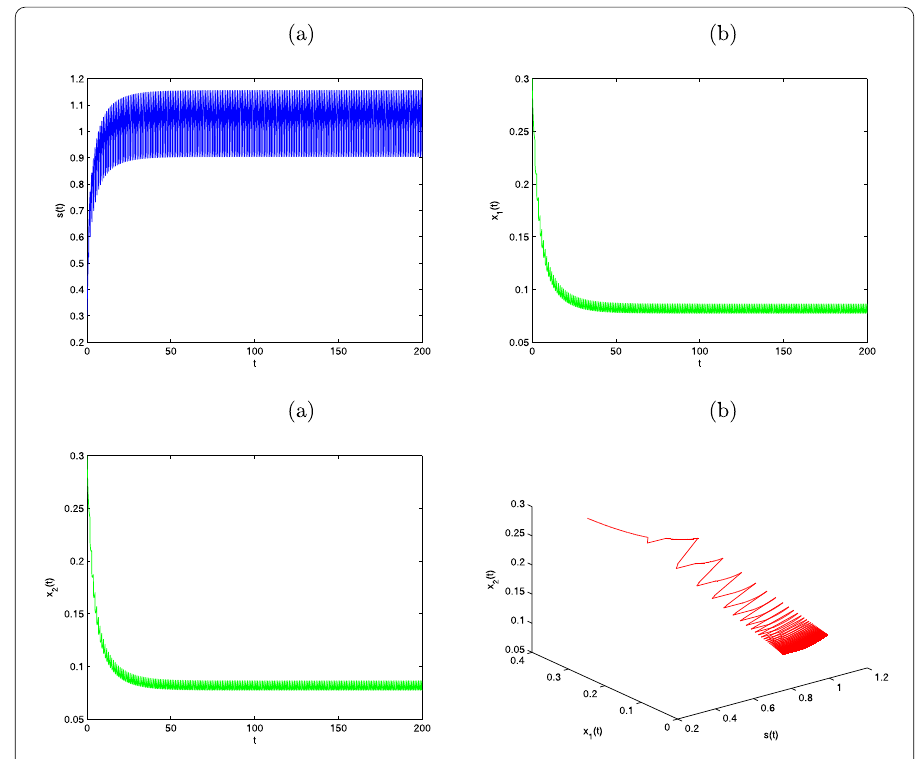
Figure 3 The permanence of system (2.1) with s (0) = 0.3, x 1 (0) = 0.3, x 2 (0) = 0.3, λ 1 = 0.5, d 1 = 0.2, β 11 = 0.5, δ 11 = 1, β 12 = 0.5, δ 12 = 1, d 11 = 0.4, d 12 = 0.4, λ 2 = 0.1, d 2 = 0.2, β 21 = 0.3, δ 21 = 1, β 22 = 0.3, δ 22 = 1, d 21 = 0.3, d 22 = 0.3, E s = 0.3, E 1 = 0.2, E 2 = 0.2, μ s = 0.2, μ 1 = 0.1, μ 2 = 0.1, μ = 0.1, l = 0.8, τ = 1; ( a ) time-series of s ( t ); ( b ) time-series of x 1 ( t ); ( c ) time-series of x 2 ( t ); ( d ) the phase portrait of the permanence of system